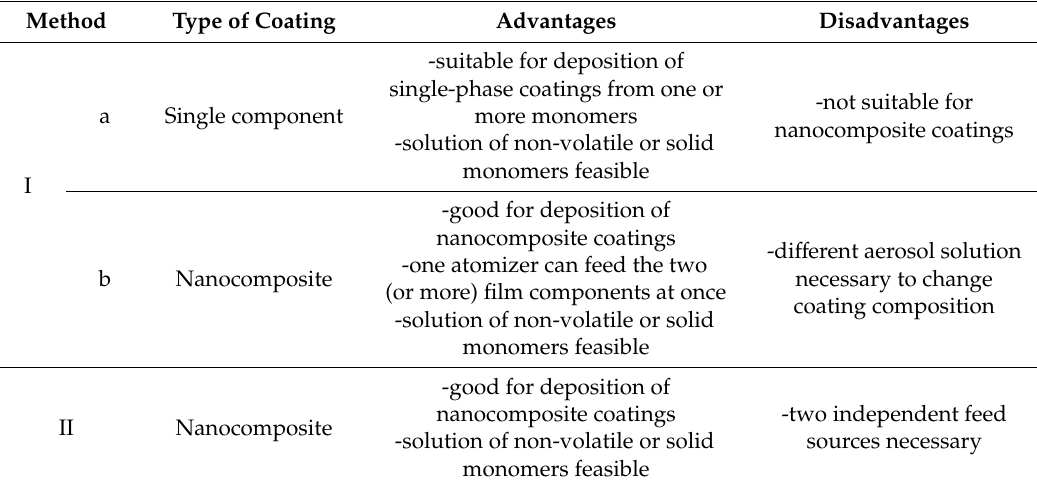
Table 2. Comparison of the di ff erent aerosol / plasma